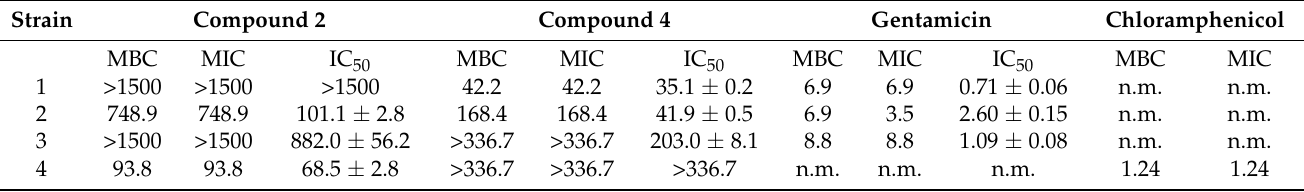
Table 2. The MBC, MIC and IC 50 values of compounds 2 and 4 and two antibiotics in µ M against 4 bacterial strains. Strain Compound 2 Compound 4 Gentamicin Chloramphenicol MBC IC 50